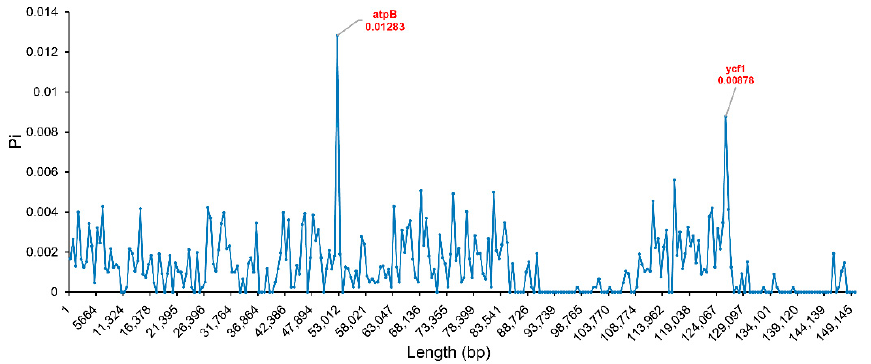
Figure 7. Sliding window analysis of the 16 Dianthus chloroplast genomes (step size, 500 bp; window length, 500 bp). x-axis: midpoint position of the window; y-axis: nucleotide diversity in each win- dow.